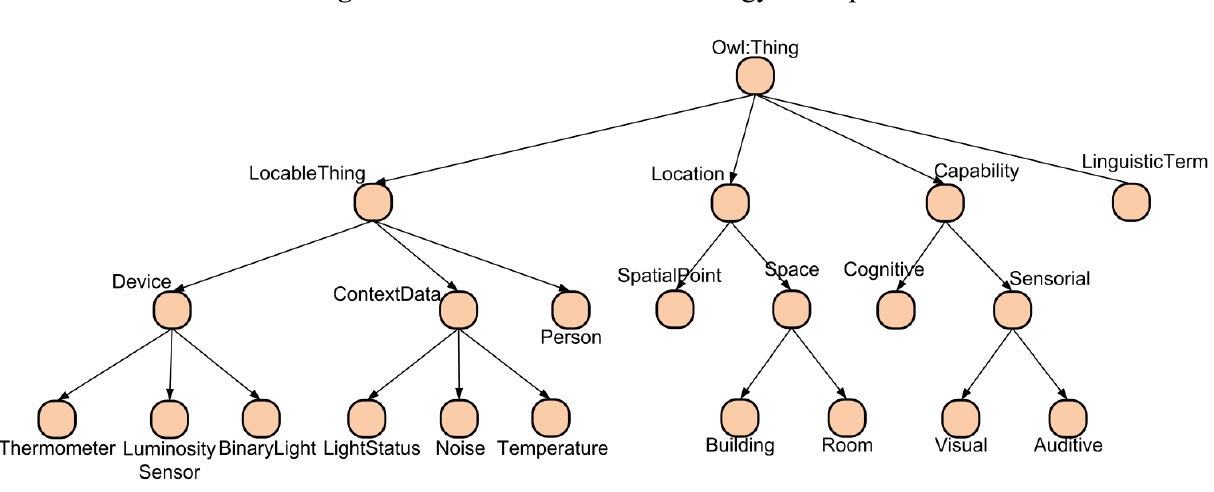
Figure 1. Subset of the main ontology